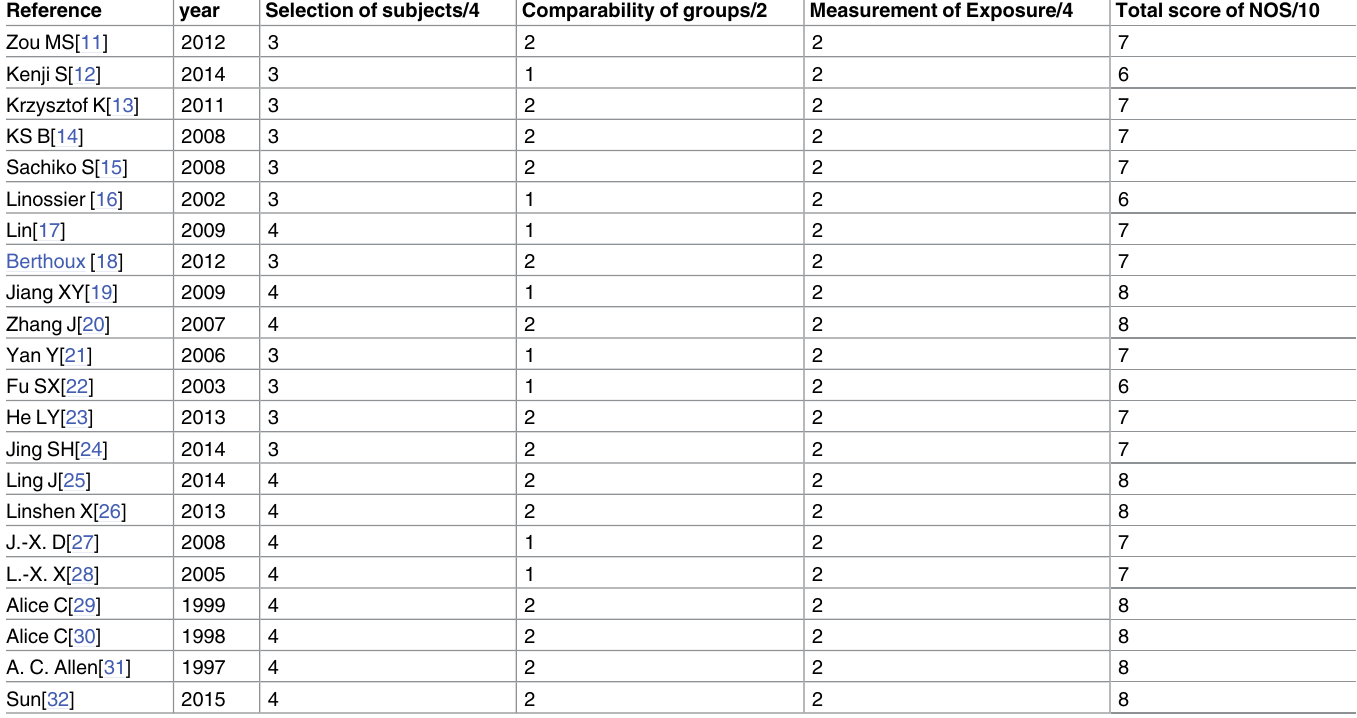
The qualities of included studies, assessed with NOS(Newcastle-Ottawa Scale), are provided in Table 2. The mean total score was 7.2 with a range from 6 to 8. Three of the 22 studies are of less good quality and scored 6, while the other 18 studies are of good quality and scored 7–8. Table 2. Quality assessment of the 22 included studies with the Newcastle-Ottawa Scale (NOS).